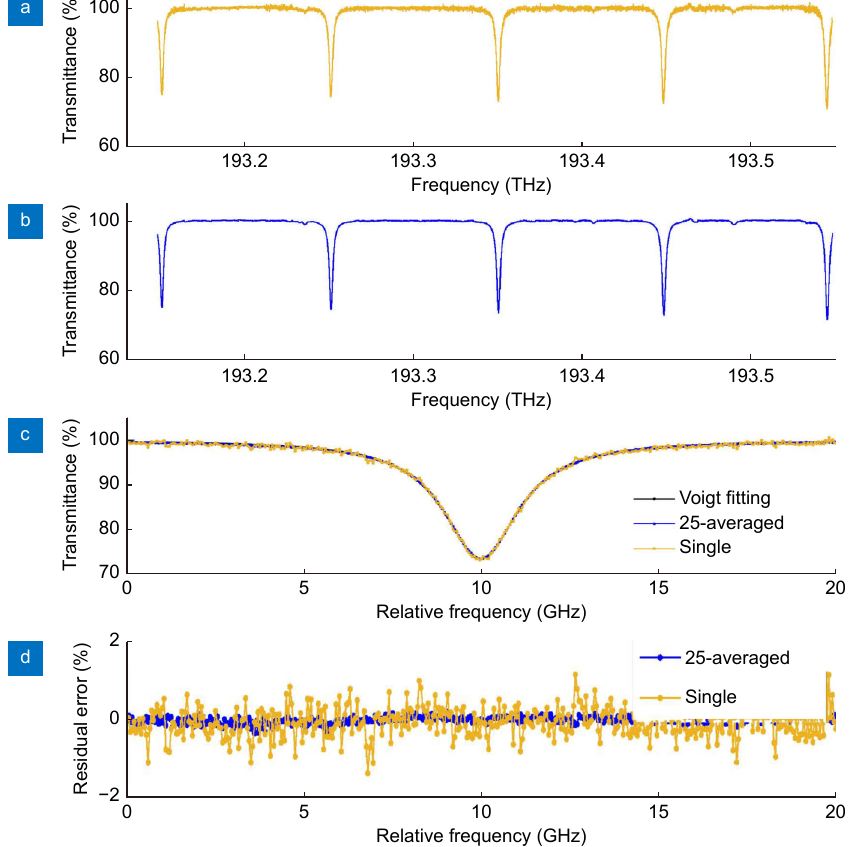
Fig. 6 | Spectra of H 13 CN gas cell obtained by ( a ) single-shot measurement and ( b ) 25 times averaged measurement, containing the absorption lines of P9-13 in the 2 v 3 band. ( c ) Measurement results and Voigt fitting curve of the P11 line. ( d ) Residual errors between the measurement res- ults and fitting curve, and the standard deviations are calculated to be 0.378% and 0.087% for the single-shot measurement and 25-averaged measurement. The spectral resolution is 50 MHz by reducing the filter bandwidth to 200 kHz.